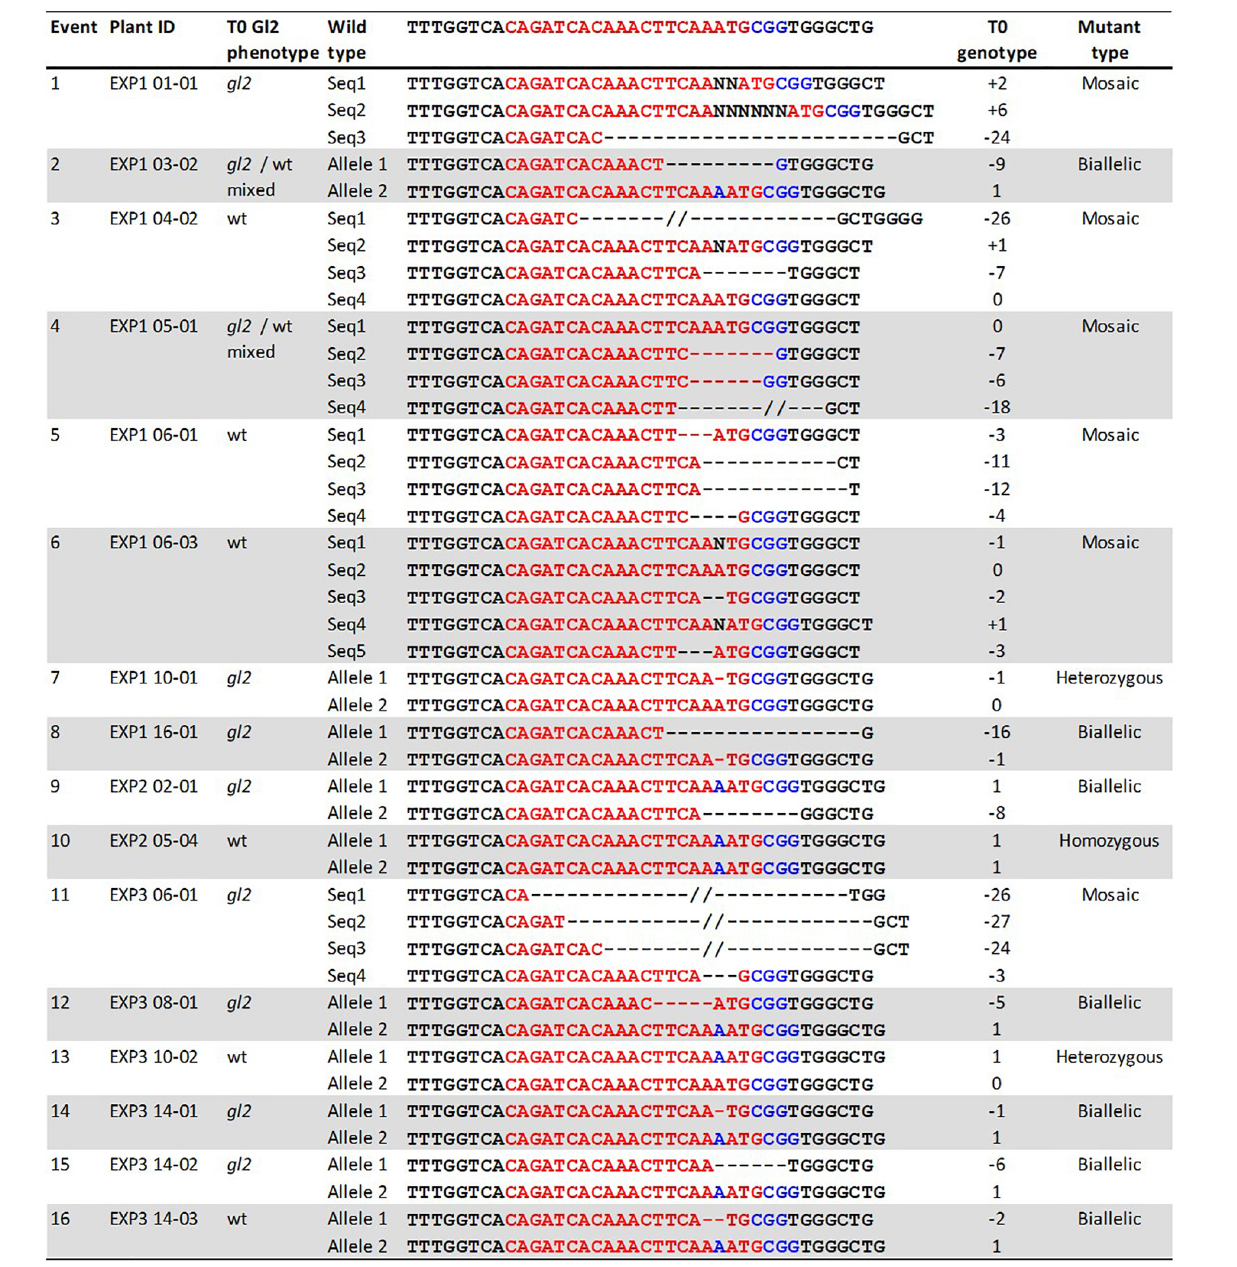
FIGURE 7 | Phenotypes and genotypes of sixteen T0 mutant events. Plant ID shows experiment ID, embryo ID, and plantlet ID (EXP-embryo-plantlet). Three gl2 phenotypes: gl2, glossy mutant phenotype; gl2 /wt mixed, both glossy mutant and wild type phenotype on the same leaf; wt, wild-type phenotype. Red letters, target sequences in Gl2 exon2; Blue letters, PAM sequences; Black letter, insertion mutations; dashed lines, deletions. T0 gl2 phenotyping is considered a preliminary screening